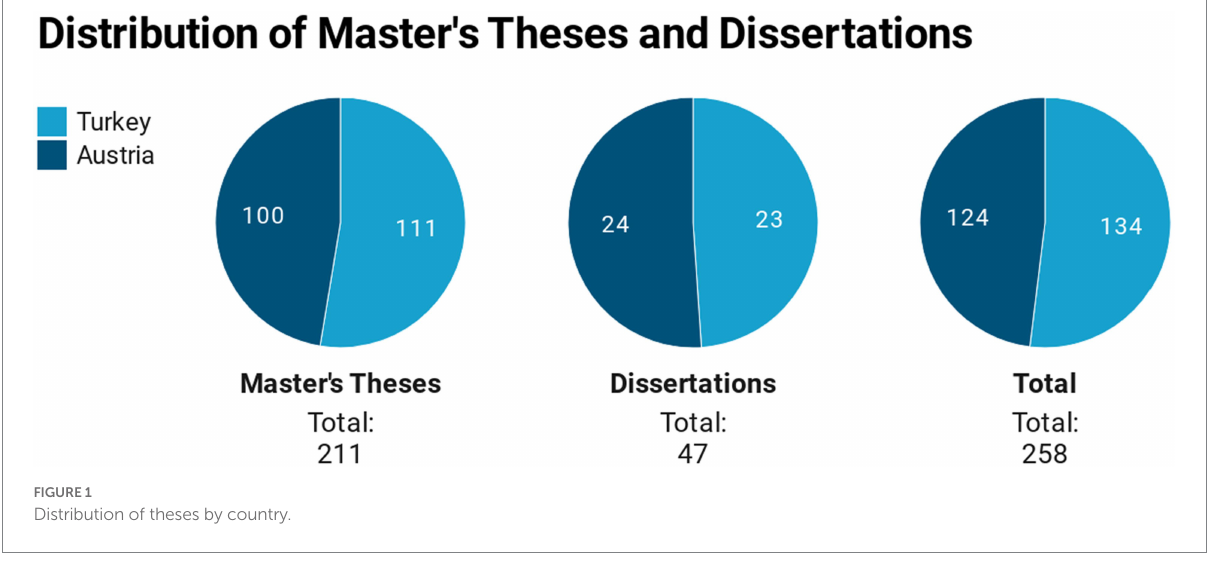
FIGURE 1 Distribution of theses by country.